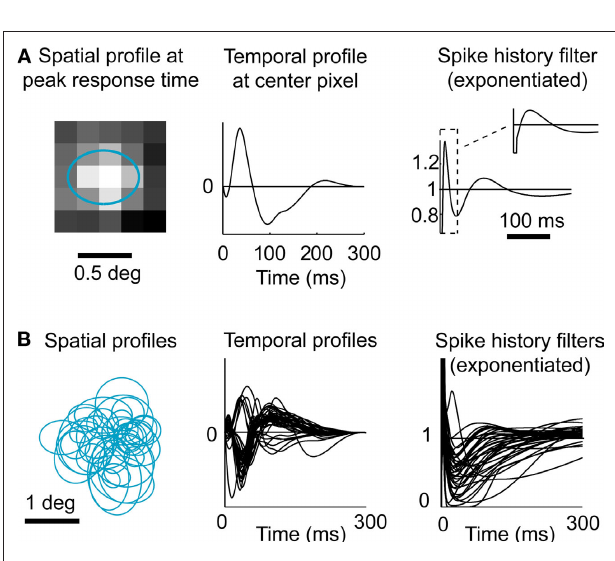
Figure 3 | Fitting LgN responses with a generalized Linear Model (gLM). (A) Model fit for a typical LGN X ON cell. In the model the linear receptive field is space–time inseparable, but here the spatial and temporal components are shown separately for simplicity. The spatial profile shown (left) corresponds to the spatial filter at the peak response time (with the 1-standard deviation contour of the best-fitting 2D Gaussian shown superimposed in blue), and the temporal profile shown (middle) is the temporal filter at the center of the RF. The exponential of the spike history temporal filter (right) is shown over the first 300 ms, and shown in more detail over the first 40 ms in inset. (B) Model fits for all cells ( n = 37). Same conventions as in (A)